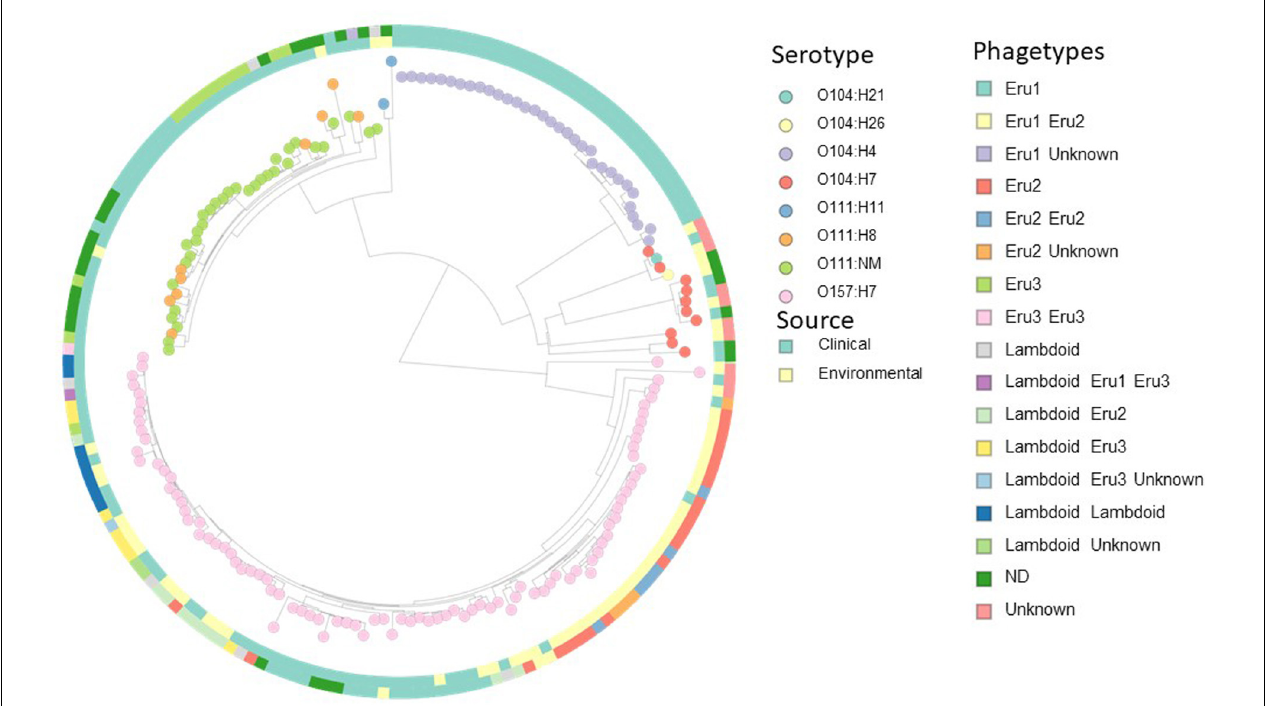
FIGURE 4 | Distance-based cluster analysis with Mashtree based on 181 STEC/EHEC strains (whole genome sequences, scaffolds, and contig assemblies) from serotypes O104:H4, O104:21, O104:H7, O104:H26, O111:H11, O111:NM, O111:H8, and O157:H7. Nodes are colored according to serotype, the inner ring is colored according to source and the outer according to phagetype (see legends). Several strains carry more than one Stx phage, and the combinations of phagetypes are indicated by colors in the outer ring. Eighteen strains carried Stx phages of neither lambdoid, Eru1, 2, nor 3 type (unknown). An interactive version